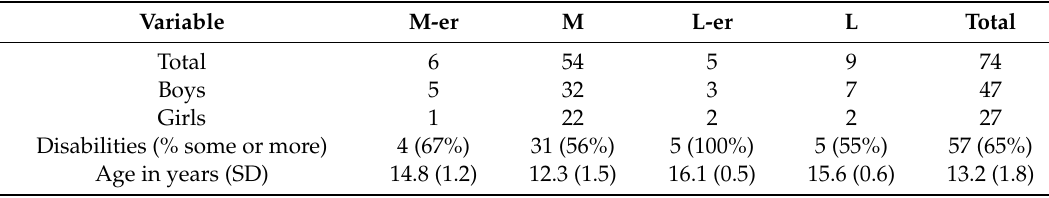
Table 2. Description of the breakdown of participants in the